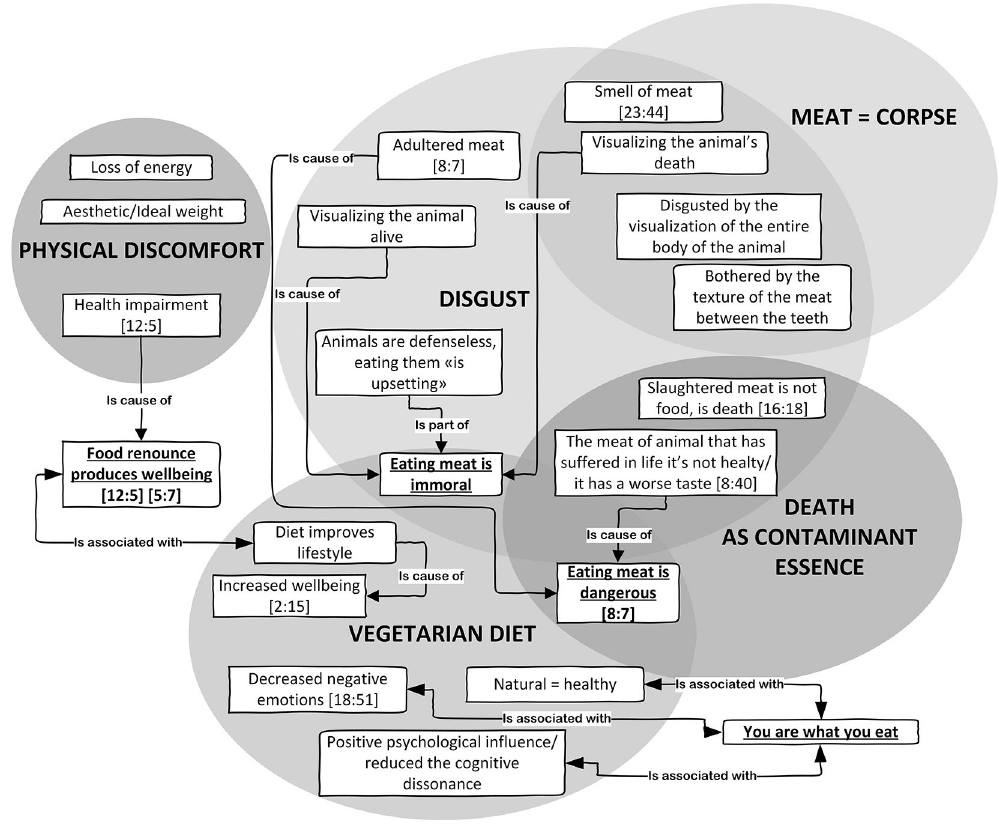
Figure 1. Death as the basis of disgust. Note. In each box of the graph, the first number in brackets indicates the quotations size (total number of quotations of the code), while the second number indicates the quotation cited in the text as